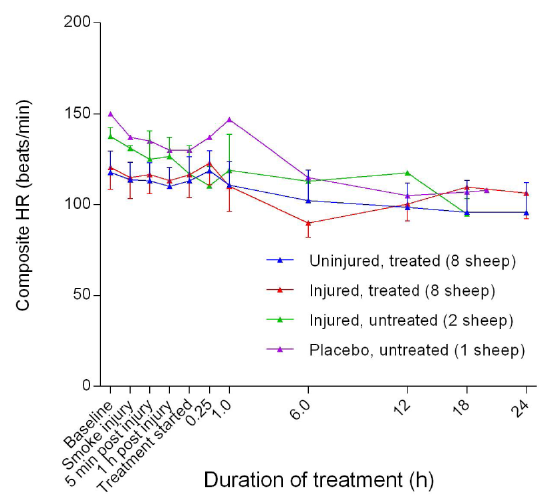
Figure 22. Composite heart rate (HR) (Mean ± SD) in smoke and non-smoke injured sheep that received extracorporeal life support as compared to that in untreated controls.